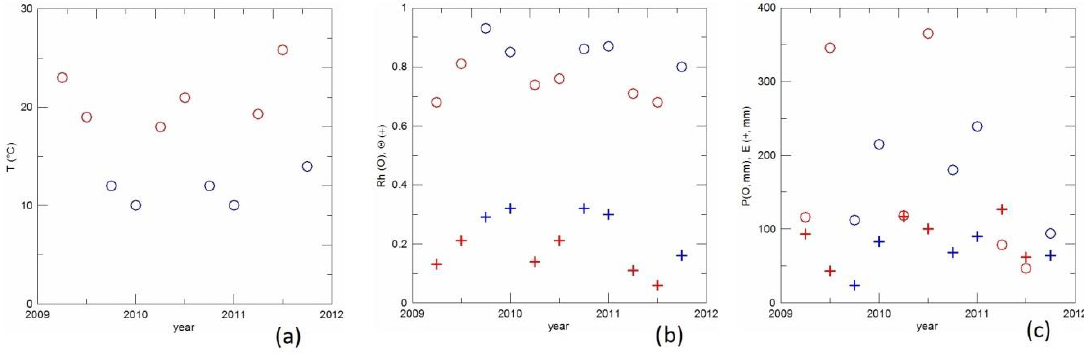
Figure 4. ( a ) Seasonal averages for air temperature; ( b ) seasonal averages for relative humidity at 10 m (o), and soil moisture at 2 cm depth (m 3 /m 3 , +); ( c ) seasonal totals for precipitation (o)